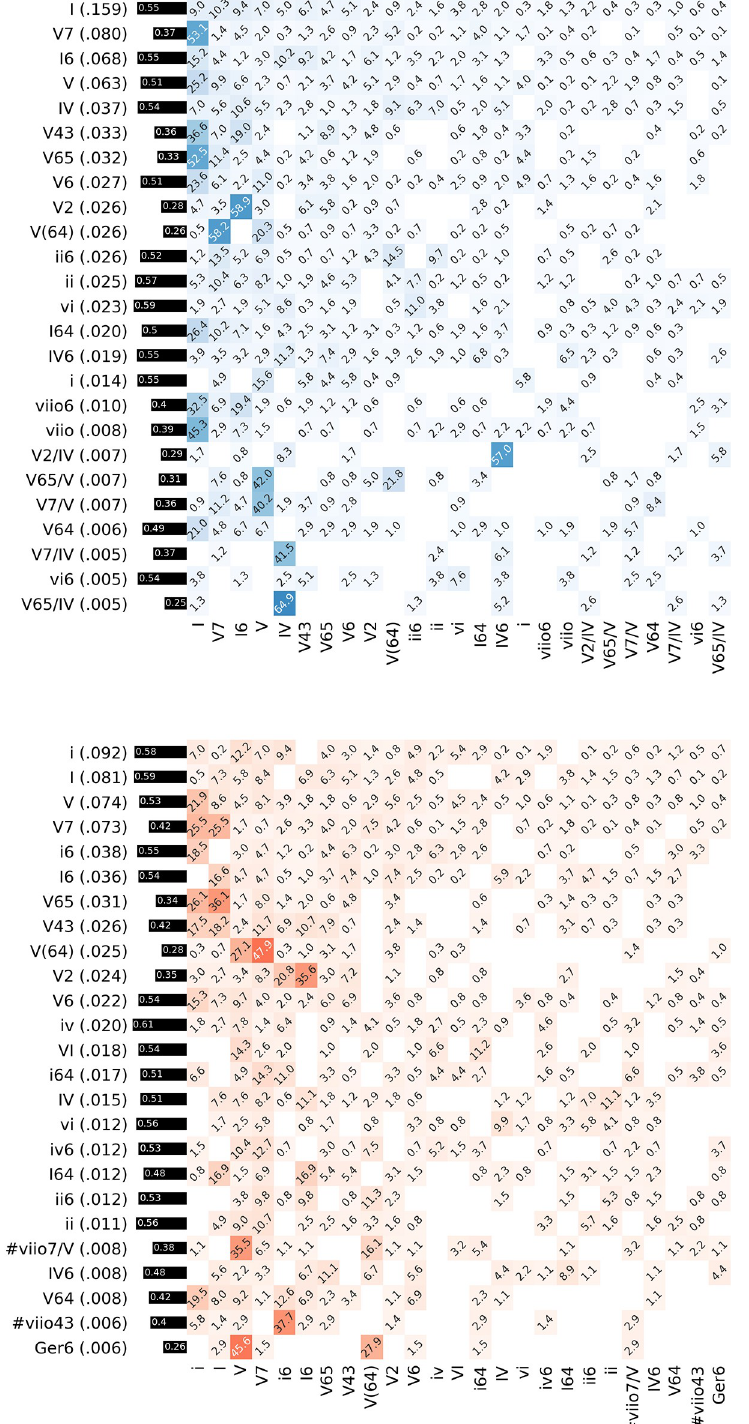
Fig 6. Chord transition probabilities. The rows in these heatmaps show the transition probabilities between the 25 top ranking chords in major (left, blue) and minor segments (right, red) as percentages. The black bars show the normalized conditional entropies over these